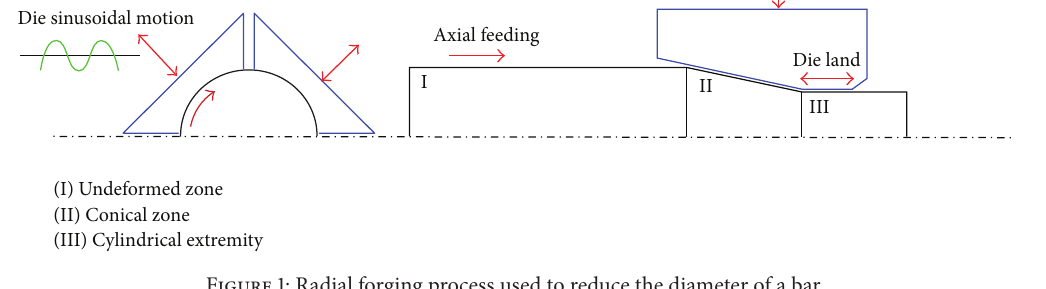
Figure 1: Radial forging process used to reduce the diameter of a bar.